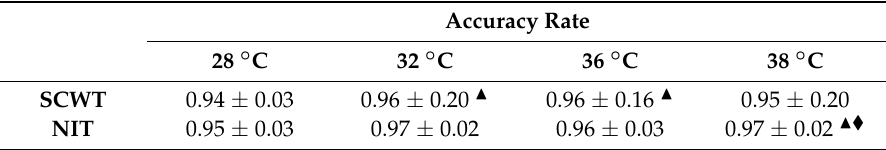
Table 4. Results of the average accuracy rates.